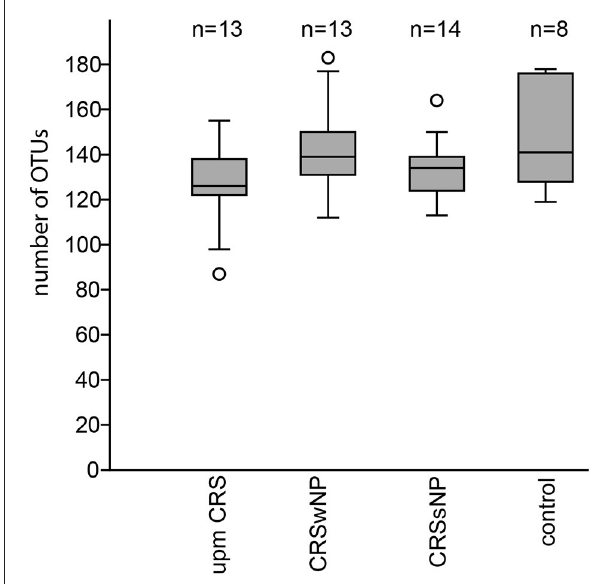
FIGURE 1 | Boxplot of the rarefied, bootstrapped number of taxa found for unilateral purulent maxillary CRS (upm CRS), CRS with nasal polyps (CRSwNP), and CRS without nasal polyps CRSsNP. The boxplot shows the 25–75% quartiles; the median is indicated by the horizontal line inside the box. The largest data points < 1.5 times the box height (“upper-inner fence”) are shown with short horizontal lines and similarly below the box. Values outside the inner fences are shown as circles.